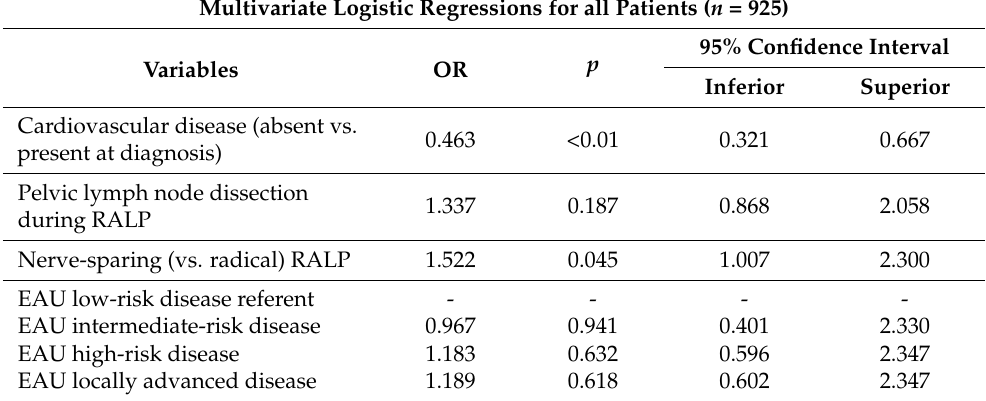
Table 4. Multivariable logistic regression analysis assessing the predictors of short-term UI in our cohort. Multivariate Logistic Regressions for all Patients ( n =